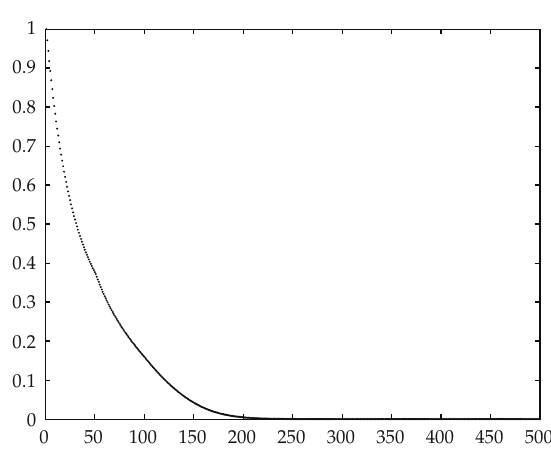
Figure 4: One-leg θ -method with θ (cid:6) 1 for (cid:4) 5.2 (cid:5)